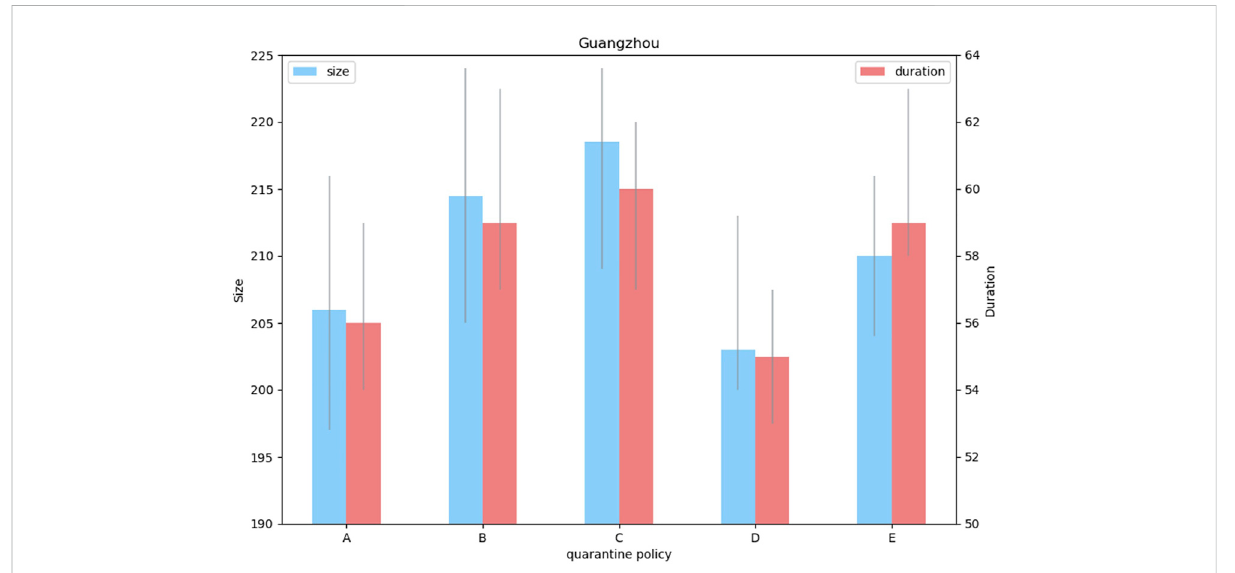
FIGURE 9 Effect of different types of quarantine policies. The correspondence between the type number and its detailed description is presented in Table1.Bluepillarsrepresentcumulativecasesandredpillarsrepresenttheepidemicduration.Theerrorbarsrepresentthe95%CIforthesimulation